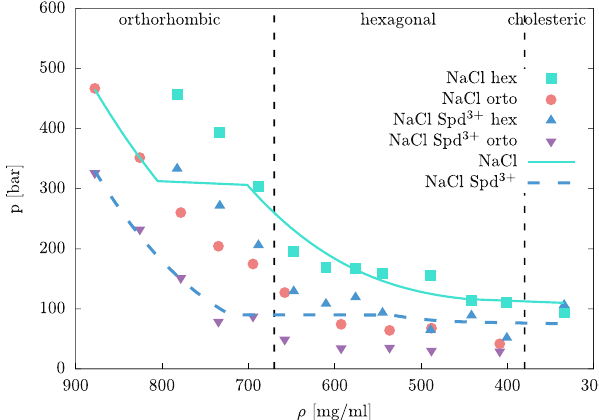
Figure 4. Same as Fig. 2. Lines are used to guide the eye and indicate the transition between the hex and orto phases obtained from the Lindemann criterion corresponding to angular fluctuations. For comparison, we add the experimentally observed domains of the orto, hex and ch phases 5